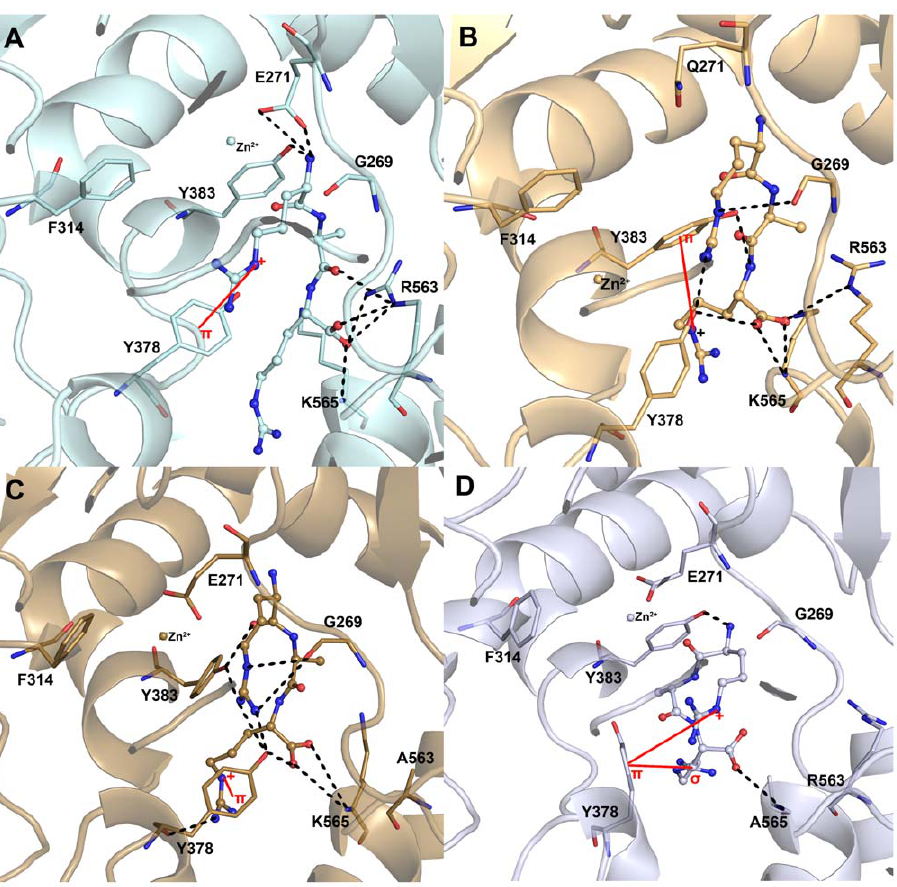
Figure 8. The binding modes of RAR at the active site of the enzyme in L-RAR systems. The binding mode of RAR in (A) WT (cyan), (B) E271Q (light orange) (C) R563A (sand), and (D) K565A (blue white) systems. The amino acid residues and RAR are shown in think stick and ball-stick forms, respectively. The metal ion (zinc) present at the active site is shown in sphere form.